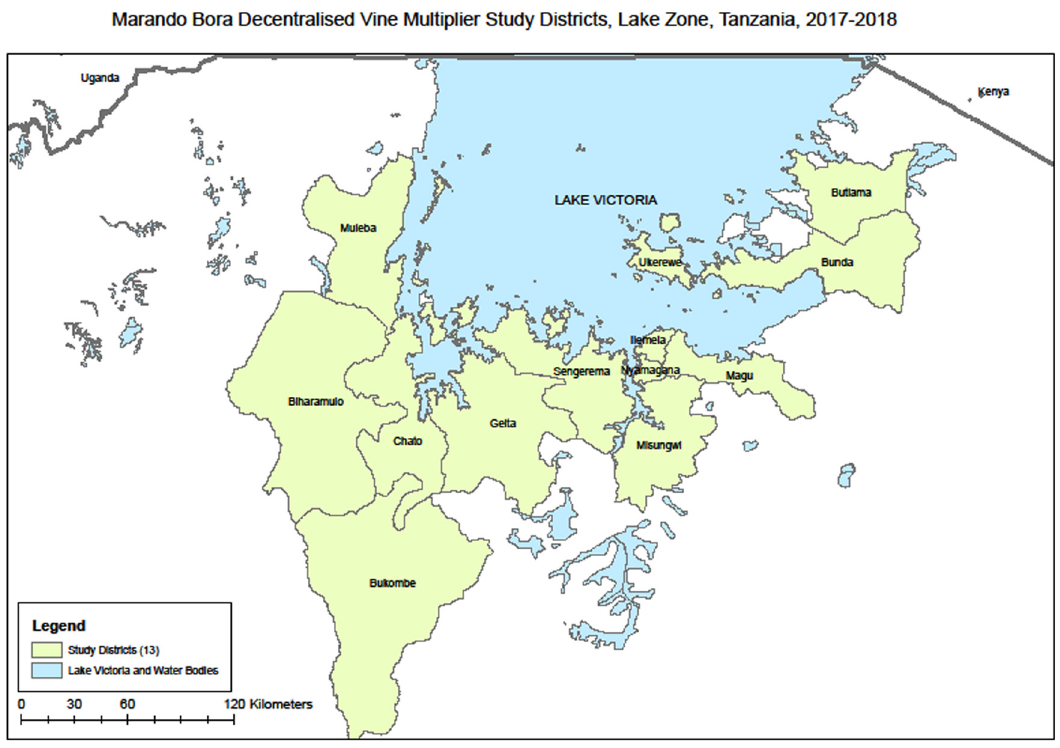
Figure 1: Marando Bora DVM Study Districts in Lake Zone, Tanzania ( Source: Global Administrative Areas ( www.gadm.org ) , OpenStreetMap and WFP GeoNode Road Network, and openAFRICA ( www.africaopendata.org ) Districts )